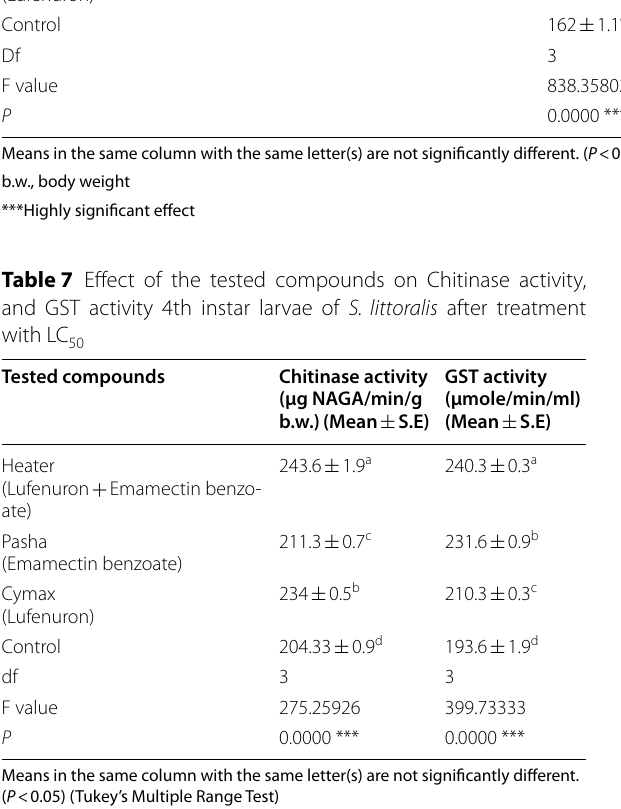
Means in the same column with the same letter(s) are not significantly different. ( P < 0.05) (Tukey’s Multiple Range Test)